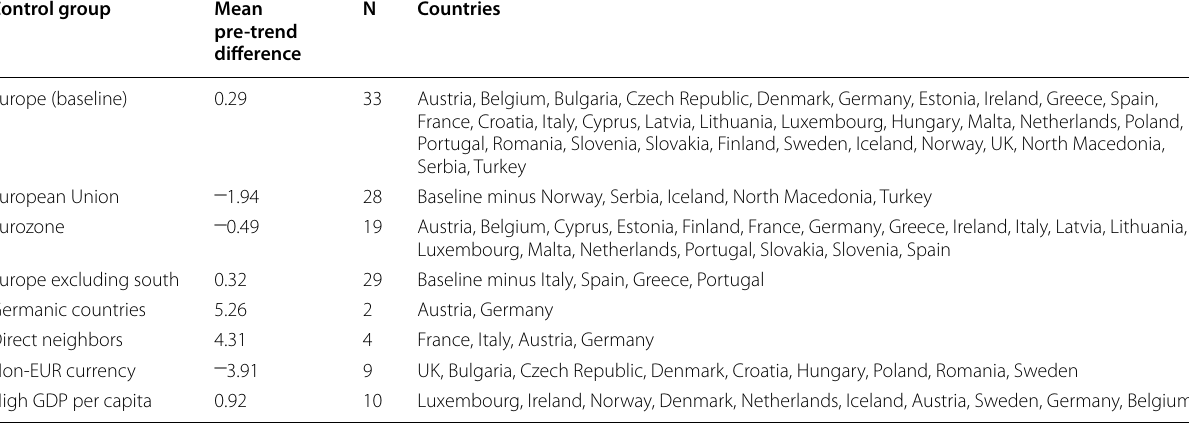
Pre-trend differences are computed for all categories of the HICP by running two time trend regressions on the Swiss and control group prices (equation 1), using monthly data from January to December 2014. The pre-trend difference is defined as the difference between the two resulting slope coefficients: b control i − b CH i . Only the average difference across all 85 HICP categories is shown. N denotes the number of countries in the proposed control